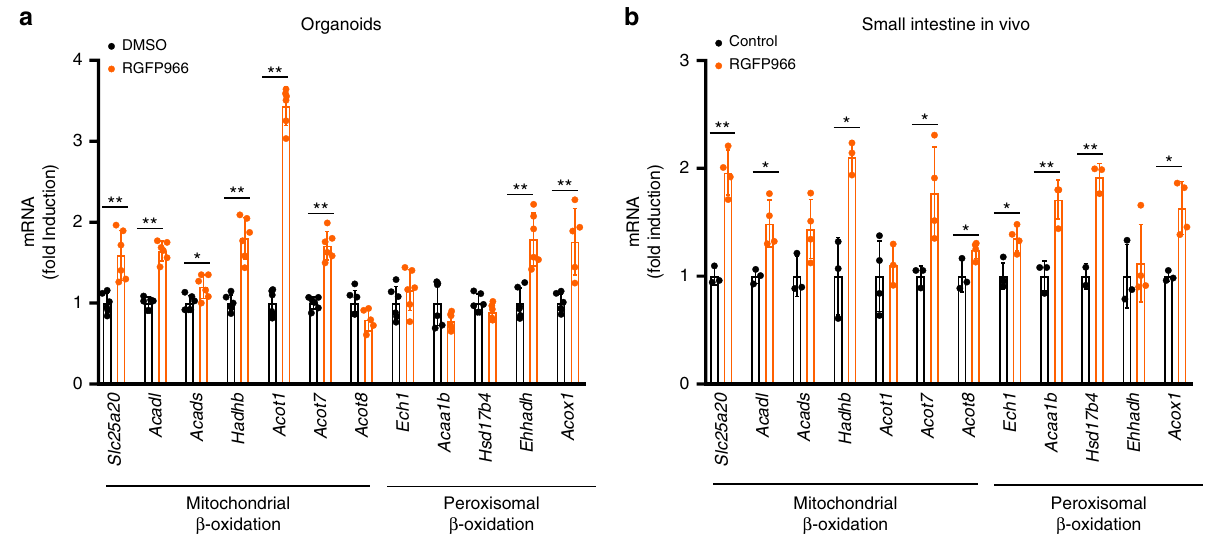
Fig. 8 Pharmacological inhibition of HDAC3 induces lipid oxidation genes in enterocytes. The HDAC3 inhibitor (RGFP966) induces expression of fatty acid oxidation genes in small intestinal organoids in vitro and in enterocytes in vivo and reduces weight gain in WT mice. a Small intestinal organoids generated from 4 – 6-week-old C57BL/6 male mice fed a standard diet were treated with RGFP966 (100 μ M) for 6 h, and gene expression changes determined by qPCR. Values shown are mean + SD or two independent experiments performed in triplicate. b C57BL/6 male mice 4 – 6 weeks of age were fed a standard chow diet supplemented with or without RGFP966 (150 mg/kg) for 8 days, and gene expression changes in the duodenum determined by qRT-PCR. Values shown in a and b are mean + SEM of n = 4 mice per treatment group, * P < 0.05, ** P < 0.005, unpaired t